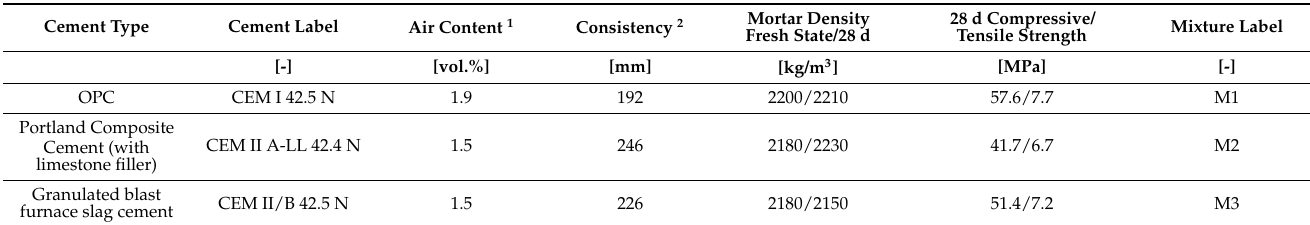
Table 1. Mortar types and